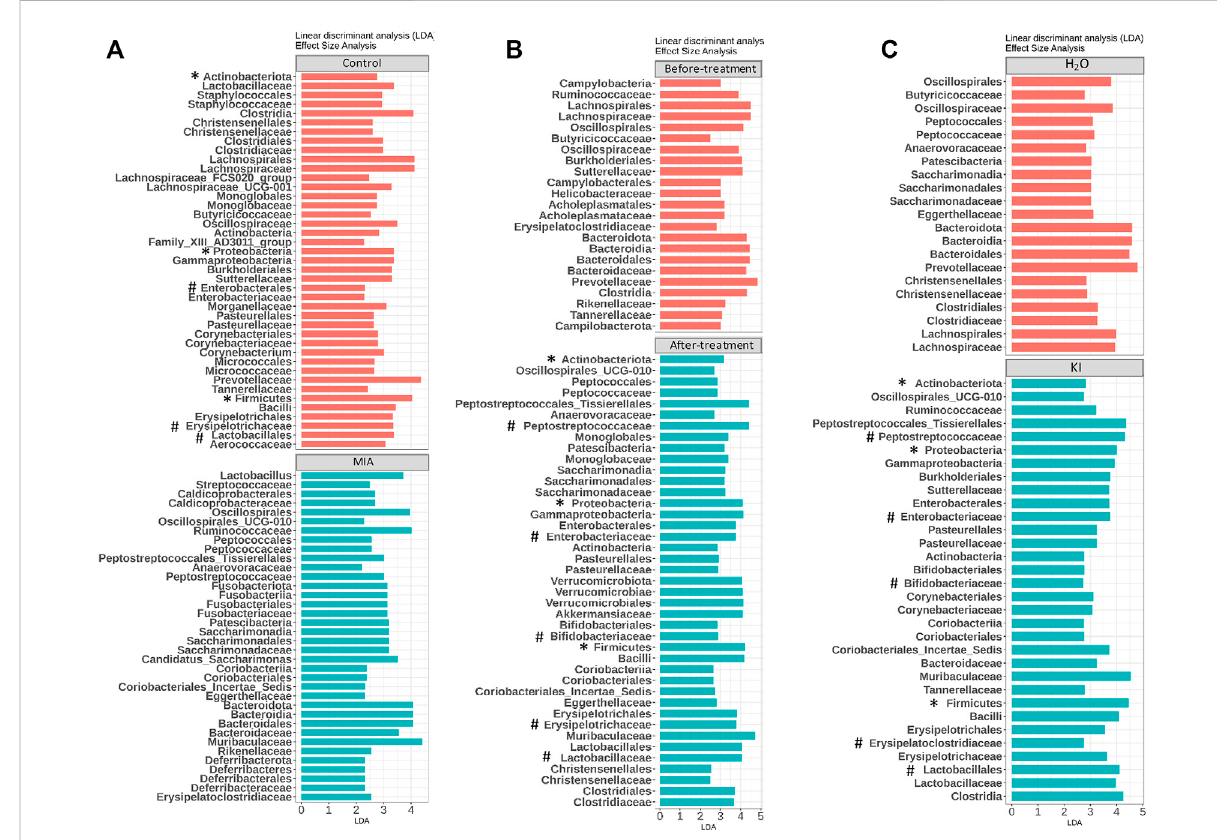
FIGURE 6 Modulation of microbiome pro fi le in maternal immune activation (MIA) offspring after oral KI Essence extract treatment. Linear discriminant analyses (LDAs) forcomparing (A) gut microbiota effect sizesofcontrol andMIA offspring, (B) gut microbiota effect sizesofMIA offspringbefore and after KI Essence extract treatment, and (C) gut microbiota effect sizes of MIA offspring after H 2 O and KI Essence extract (KI) treatment. Signi fi cant biomarkers are de fi ned as taxa with LDA score (log 10 ) ≥ 2. p and # indicated that abundance of bacterial species at the phylum and family levels was signi fi cantly different, respectively. n = 5 for control and MIA group; n = 5 for before treatment group; n = 3 for after treatment, H 2 O, and KI Essence extract treatment